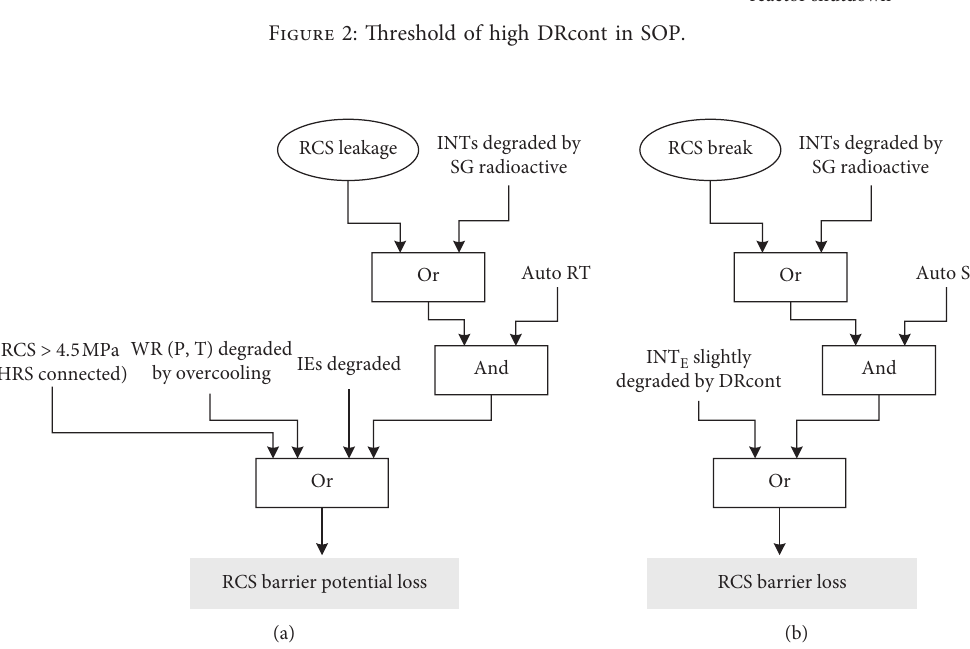
Figure 3: RCS barrier initial